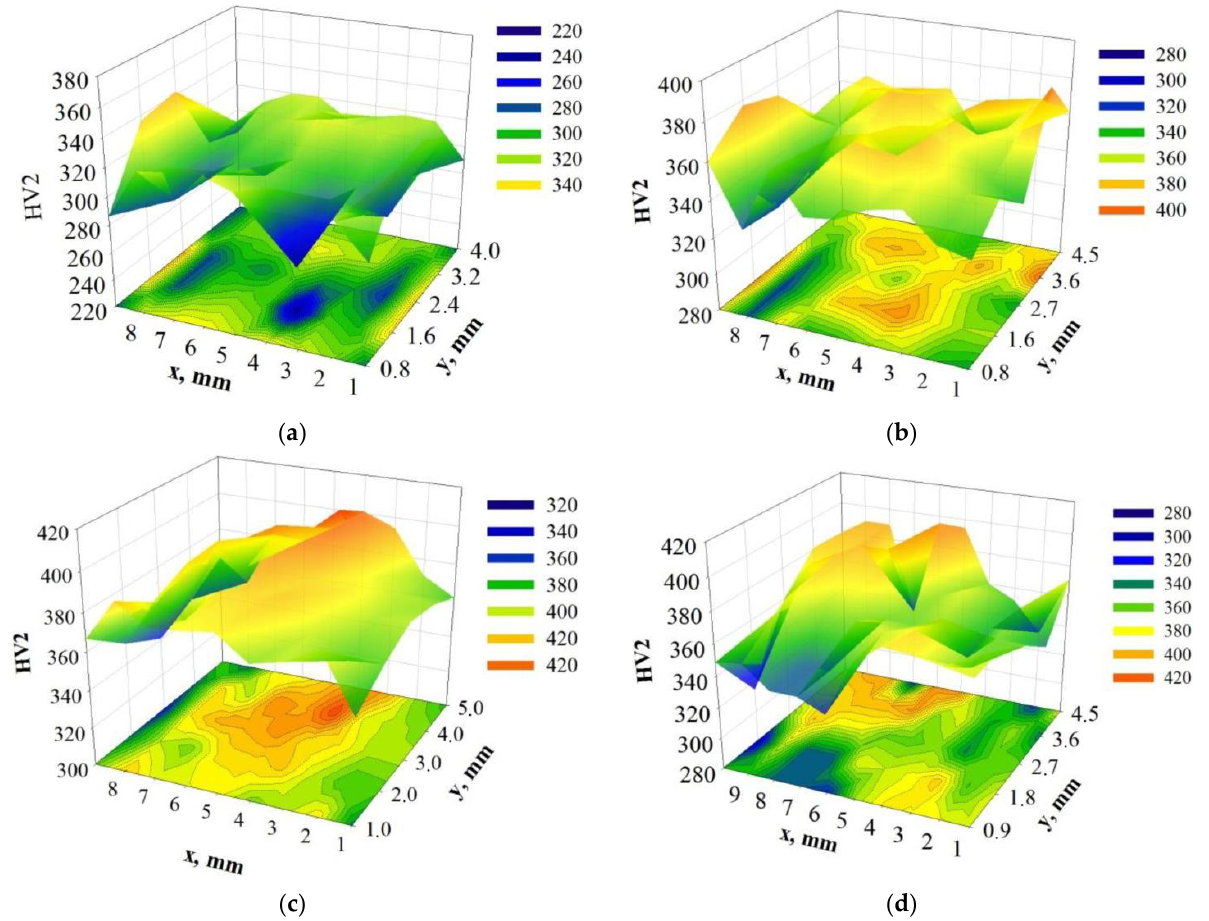
Figure 9. Hardness HV2 maps of specimens after testing at strain rate: ( a ) 0.001, ( b ) 0.01, ( c ) 0.1, ( d ) 1 s −1 .